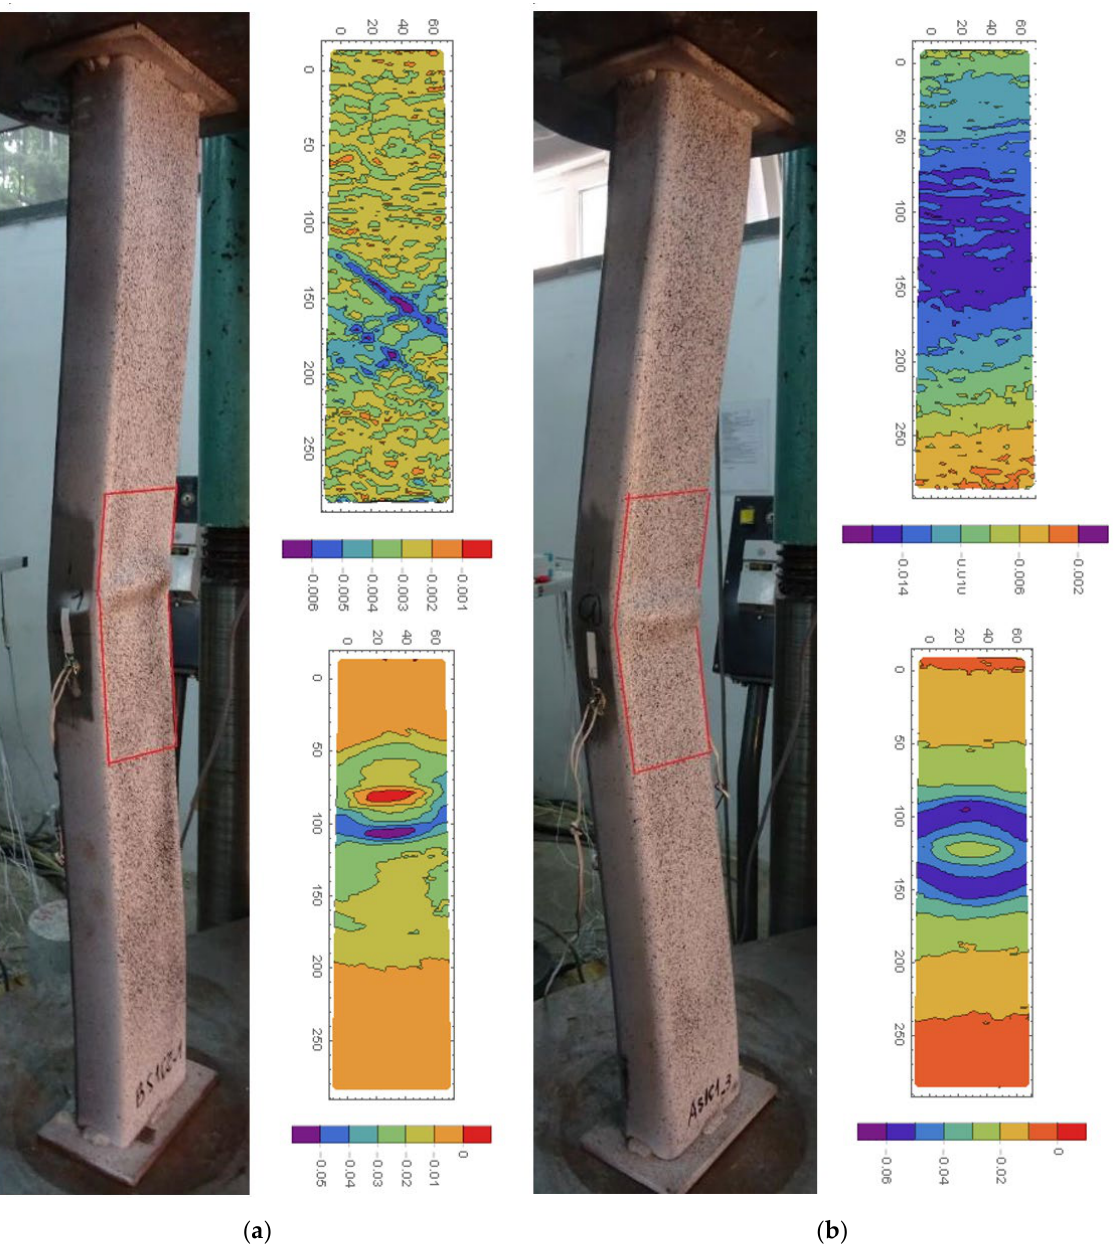
Figure 23. Longitudinal strains ε xx in slender columns: ( a ) BS1C2_1 ( ξ = 1.52) and ( b ) AS1C1_3 ( ξ = 4.12). Description in the text.